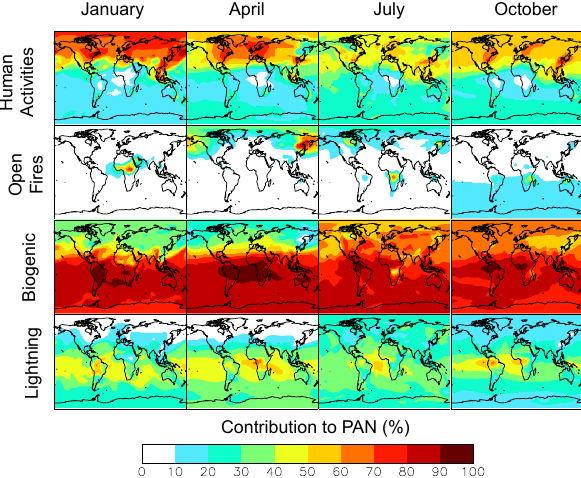
Fig. 7. Sensitivity of PAN to different emission types. Results are shown as relative decreases of monthly mean total PAN columns in sensitivity simulations with individual emission types shut off. Biogenic signifies NMVOCs